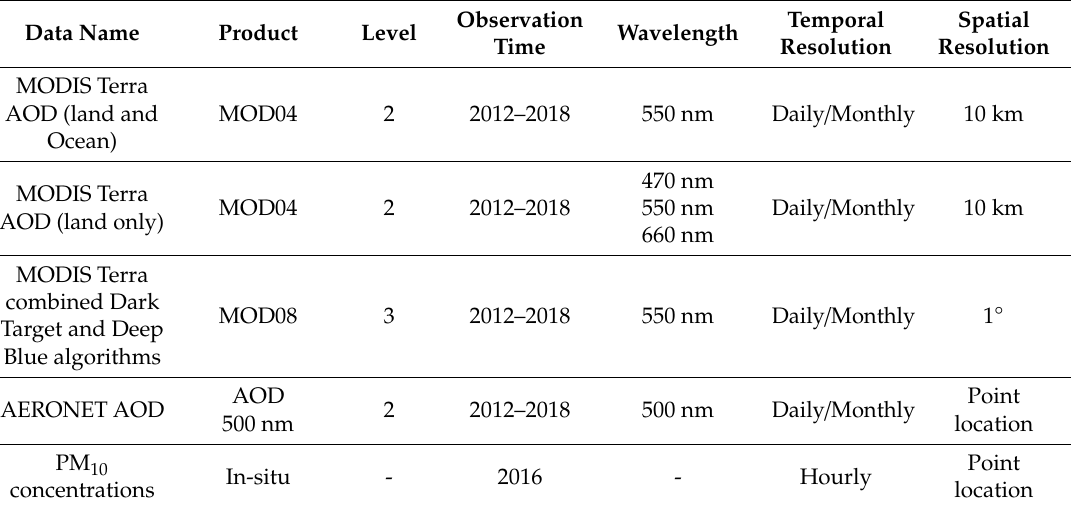
Table 1. Characteristics and sources of data used in this study. MODIS: Moderate Resolution Imaging Spectroradiometer; AOD: aerosol optical